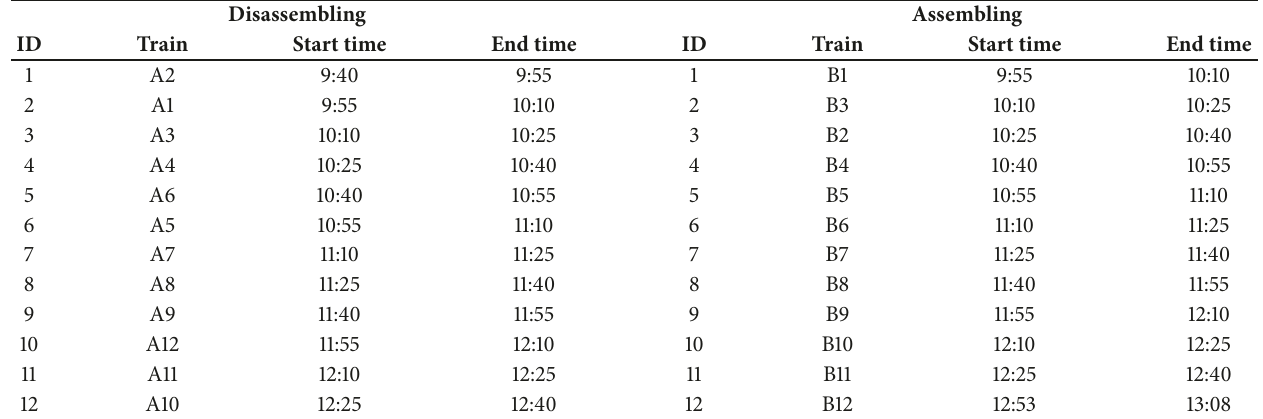
Figure 5: The procedure of Tabu search. Table 2: Disassembling and assembling